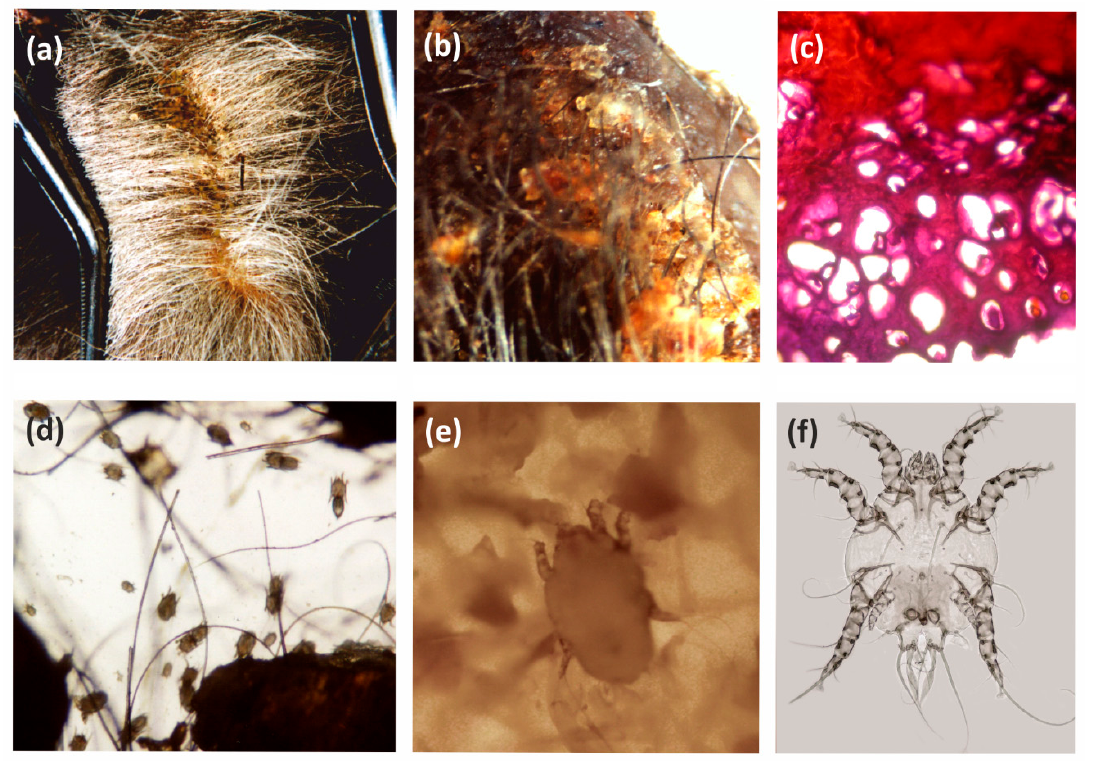
Figure 3. Chorioptes bovis and chorioptosis in the European bison: ( a , b ) macroscopy skin lesions; ( c ) histopathological changes in the skin; ( d ) Mites in the scrapings; ( e ) Female in the scrapings; ( f ) Male, microscope slide.